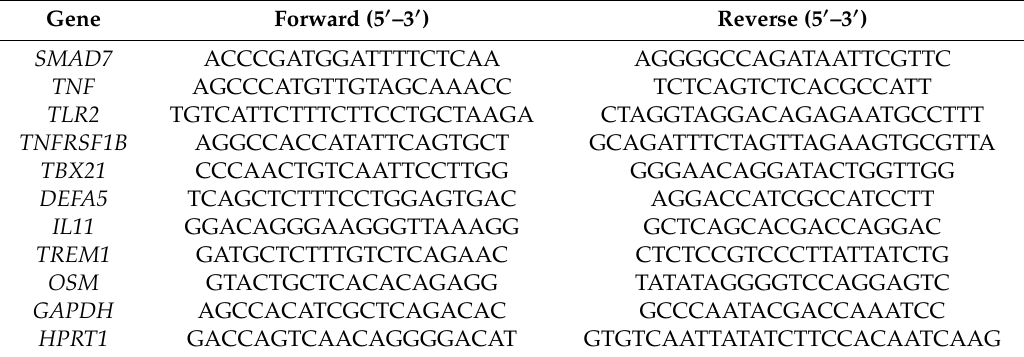
Table 2. Oligonucleotide sequences used for PCR amplification.